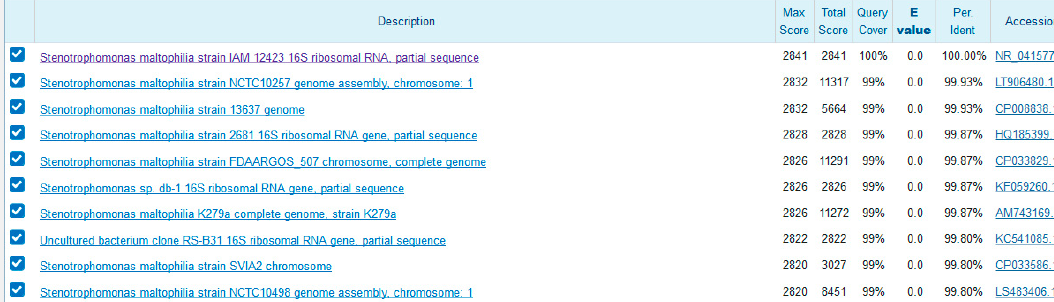
Figure 2. Nucleotide Basic Local Alignment Search Tool (BLAST) results for the isolated strain: 16a. The first ten homologues were selected for phylogenetic tree construction.